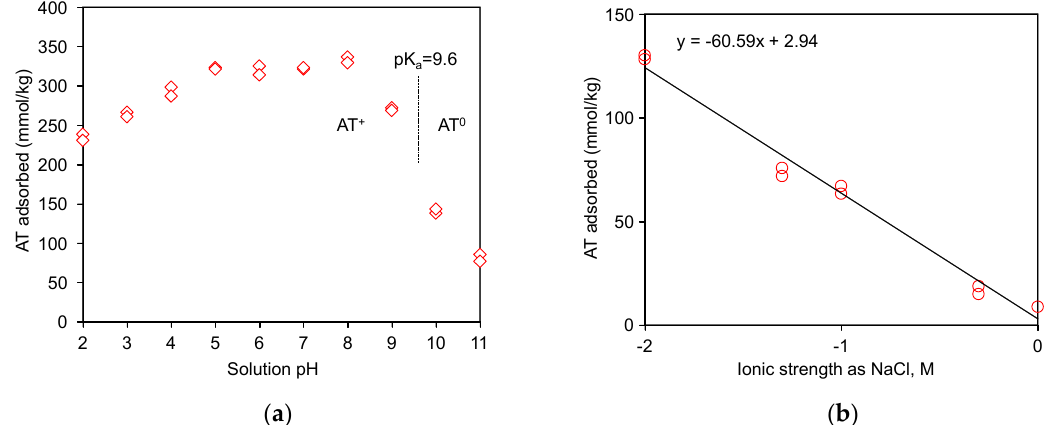
Figure 5. AT uptake on SAz-2 as affected by equilibrium solution pH ( a ) and ionic strengths ( b ) at an initial AT concentration of 3 mmol/L.